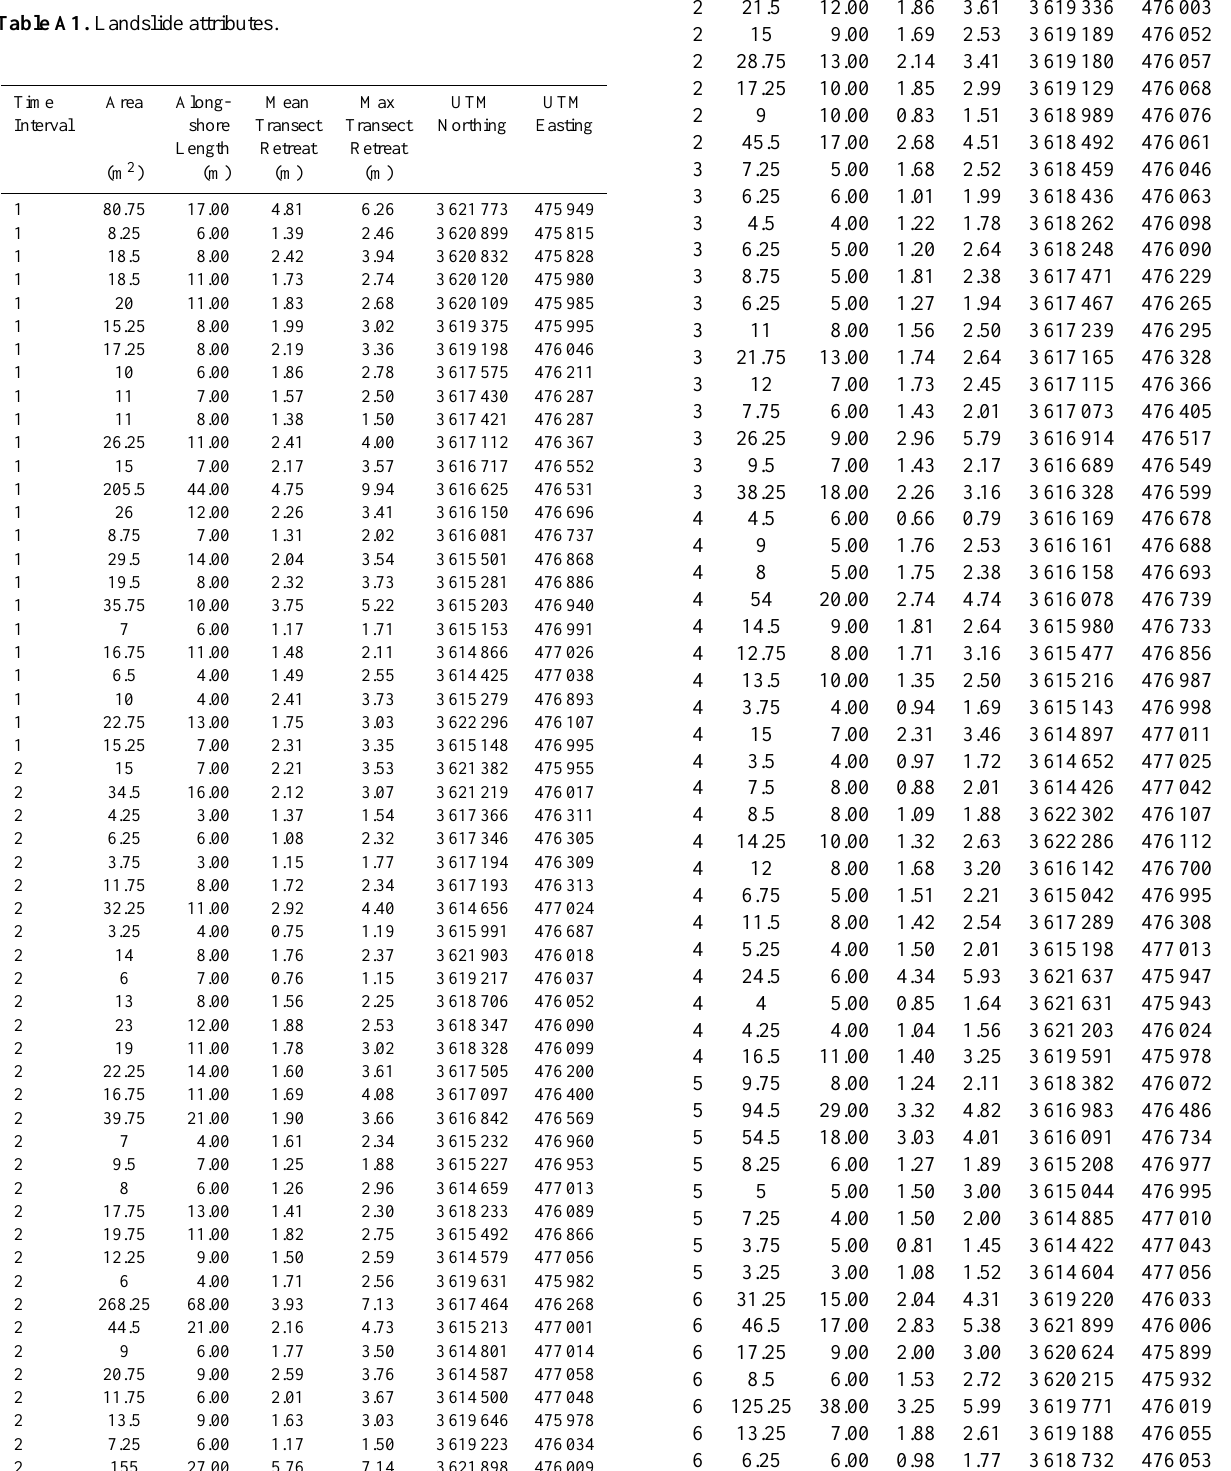
Table A1. Landslide